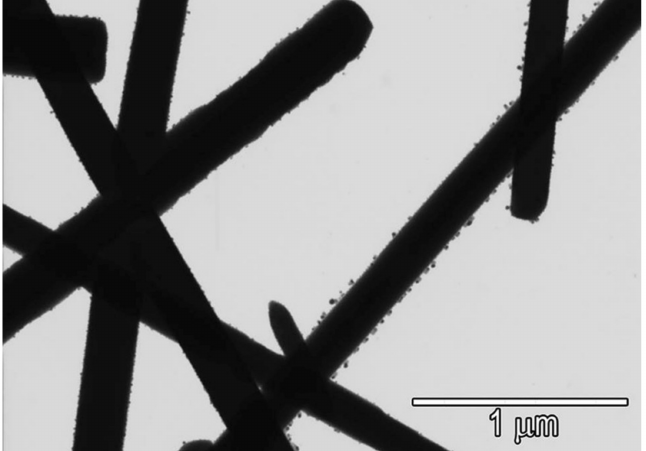
Figure 4. Scanning transmission electron microscopy micrograph of β -AgVO 3 ( × 200,000 magnifica- tion). The silver vanadate nanowires presented a diameter of approximately 150 nm, coated with semi-spherical silver nanoparticles with dimensions of 25 nm.